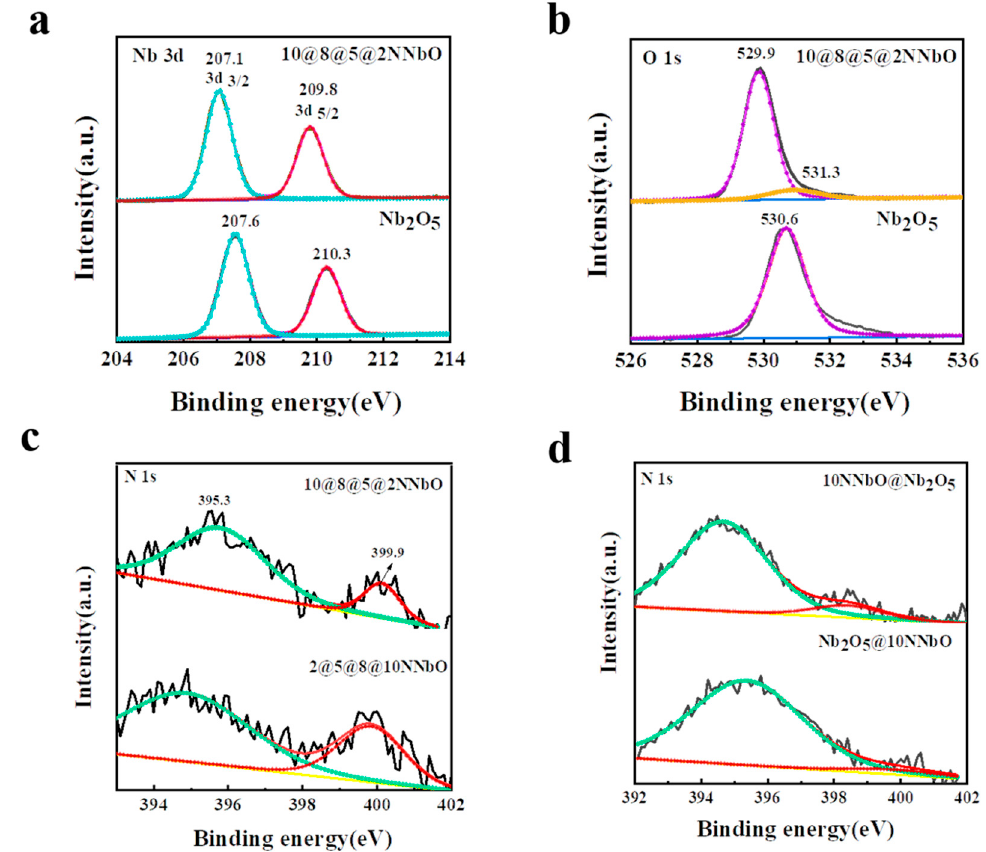
Figure 3. X-ray photoelectron spectra (XPS): ( a ) Nb 3d; ( b ) O 1s for 10@8@5@2NNbO and Nb 2 O 5 and ( c , d ) N 1s spectra for 2@5@8@10NNbO, 10@8@5@2NNbO and Nb 2 O 5 @10NNbO, 10NNbO@ Nb 2 O 5 .